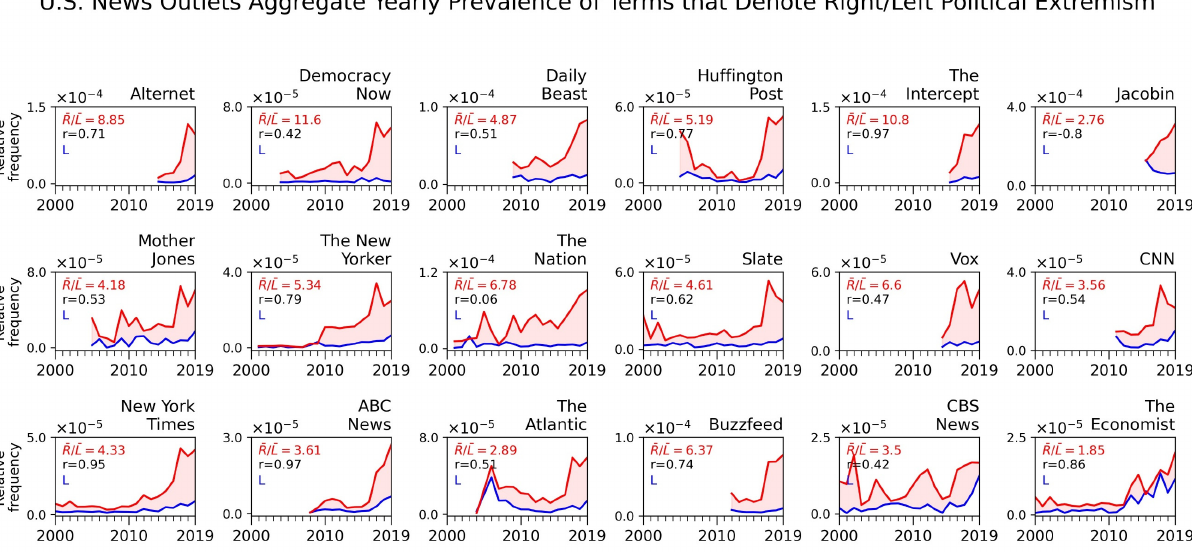
Figure 4. Yearly prevalence of an aggregate set of terms denoting far-right (red line) and far-left (blue line) political extremism in popular U.S. news media outlets. The colored area between time series for each outlet is used to highlight the dominant prevalence. Red areas indicate higher average prevalence of far-right denoting terms. Conversely, blue areas indicate higher prevalence of far-left denoting terms. The average prevalence ratio between both time series ( 𝑅(cid:3364) / 𝐿(cid:3364) or 𝐿(cid:3364)/𝑅(cid:3364) ) is also color- coded according to which ratio is dominant. The Pearson correlation coefficient, r, between the time series is shown on the top left of each subplot. The political bias from each outlet, according to the AllSides Media Bias Chart 2019 v1.1 (AllSides 2019), is indicated with L (left-leaning), C (center- leaning) and R (right-leaning).